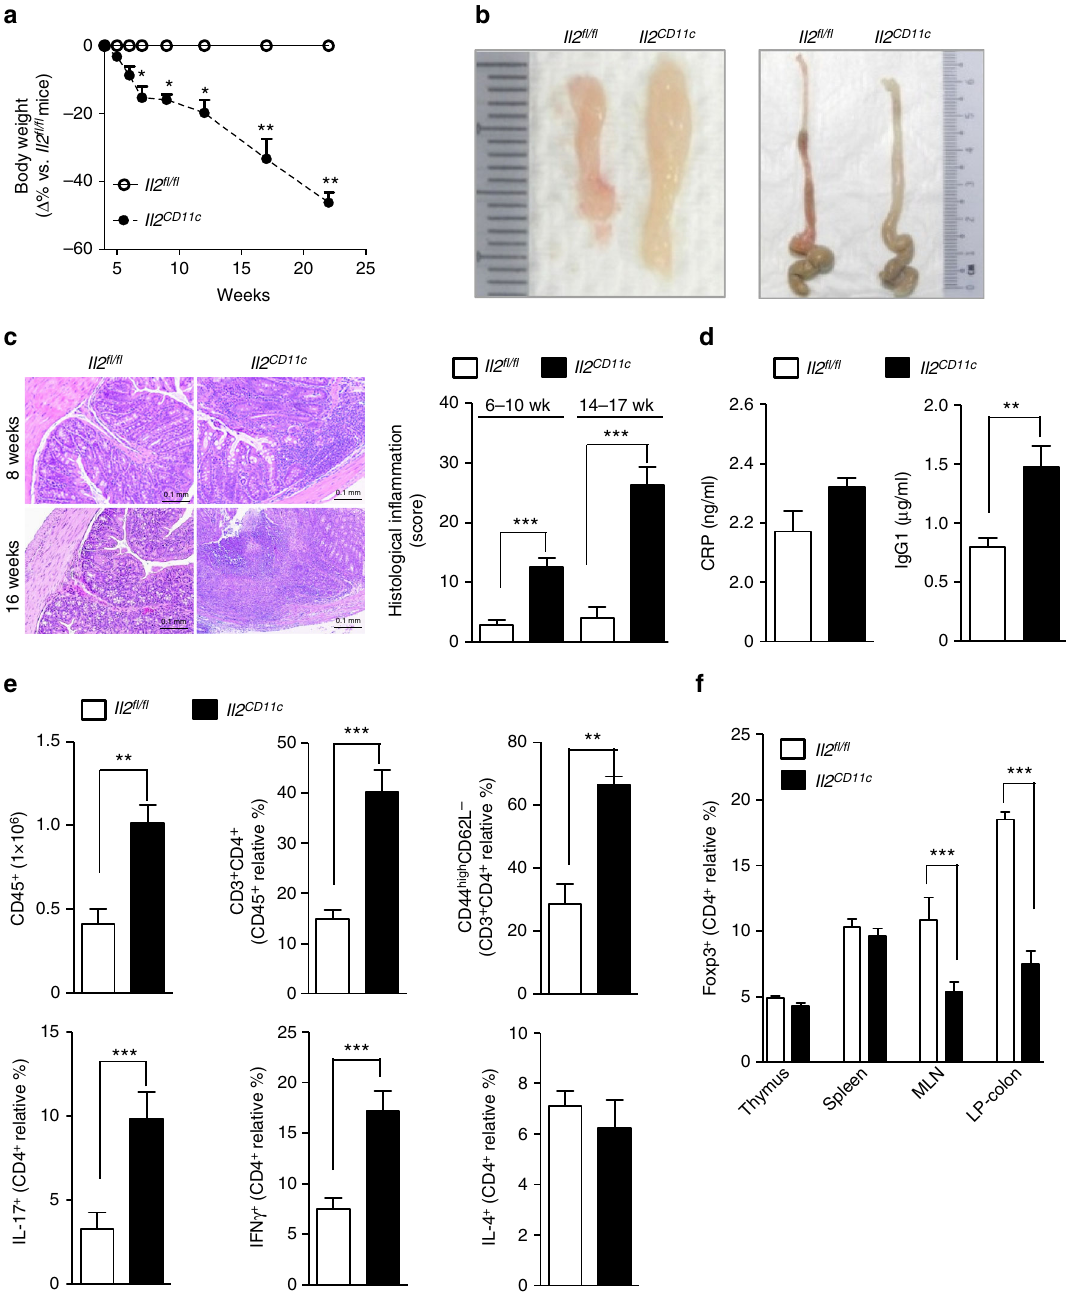
Fig. 6 Th1/Th17-cell expansion and Treg-cell contraction in the gut of Il2 CD11c mice. a Change in body weight (expressed as Δ percentage relative to the mean weight of the control group) in Il2 CD11c mice compared to Il2 fl / fl mice. Data represent the means ± standard error ( n = 20 mice/group). * P < 0.05, ** P < 0.01. b Representative images of the MLN (left) and colons (right) from Il2 CD11c and Il2 fl / fl mice aged 10 weeks old. c H&E staining of colon sections showing massive leukocyte in fi ltration in Il2 CD11c compared to Il2 fl / fl mice (×10 magni fi cation, scale bar 0.1 mm). Histological in fl ammation index of the colon was also evaluated over time. Data represent the means ± standard error (14 mice/group aged 6 – 10 weeks old, and 6 mice/group aged 14 – 17 weeks old). *** P < 0.001. d Plasma levels of C-reactive protein (CRP) and IgG1 in the sera of Il2 CD11c and Il2 fl / fl mice. Data represent the means± standard error (5 – 7 mice/group). ** P < 0.01. e Immune phenotype of LP-colon mononuclear cells from Il2 CD11c and Il2 fl / fl mice. Data represent the means ± standard error of the total number of mononuclear cells obtained from the LP, the percentage of total and antigen-experienced CD44 high CD62L - CD4 + T cells, and the proportion of CD4 + T cells producing IL-17, IFN γ or IL-4. f Frequency of FoxP3 + Treg cells in thymus, spleen, MLN, and LP-colon isolated from Il2 CD11c and Il2 fl / fl mice. Data represent the means± standard error of 3 – 4 experiments ( n = 2 – 4 mice/group per experiment, aged 6 – 10 weeks). ** P < 0.01, *** P < 0.001. LP lamina propria, MLN mesenteric lymph